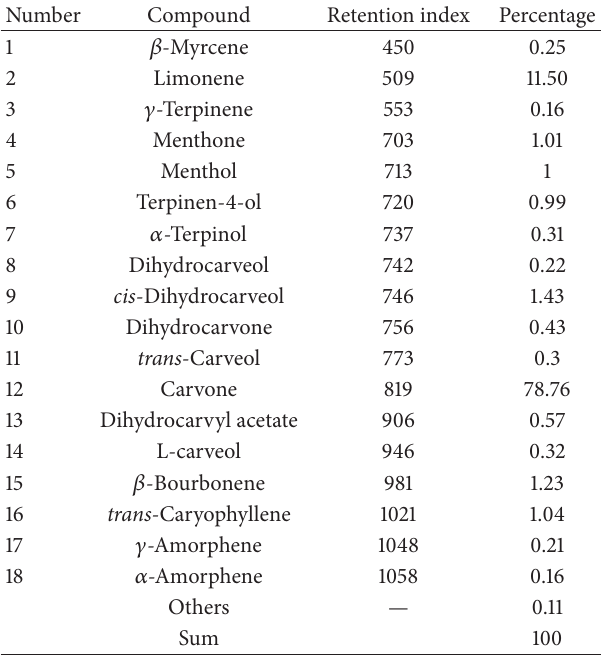
Table 1: Essential oil composition of M. spicata identified by GC- MS.